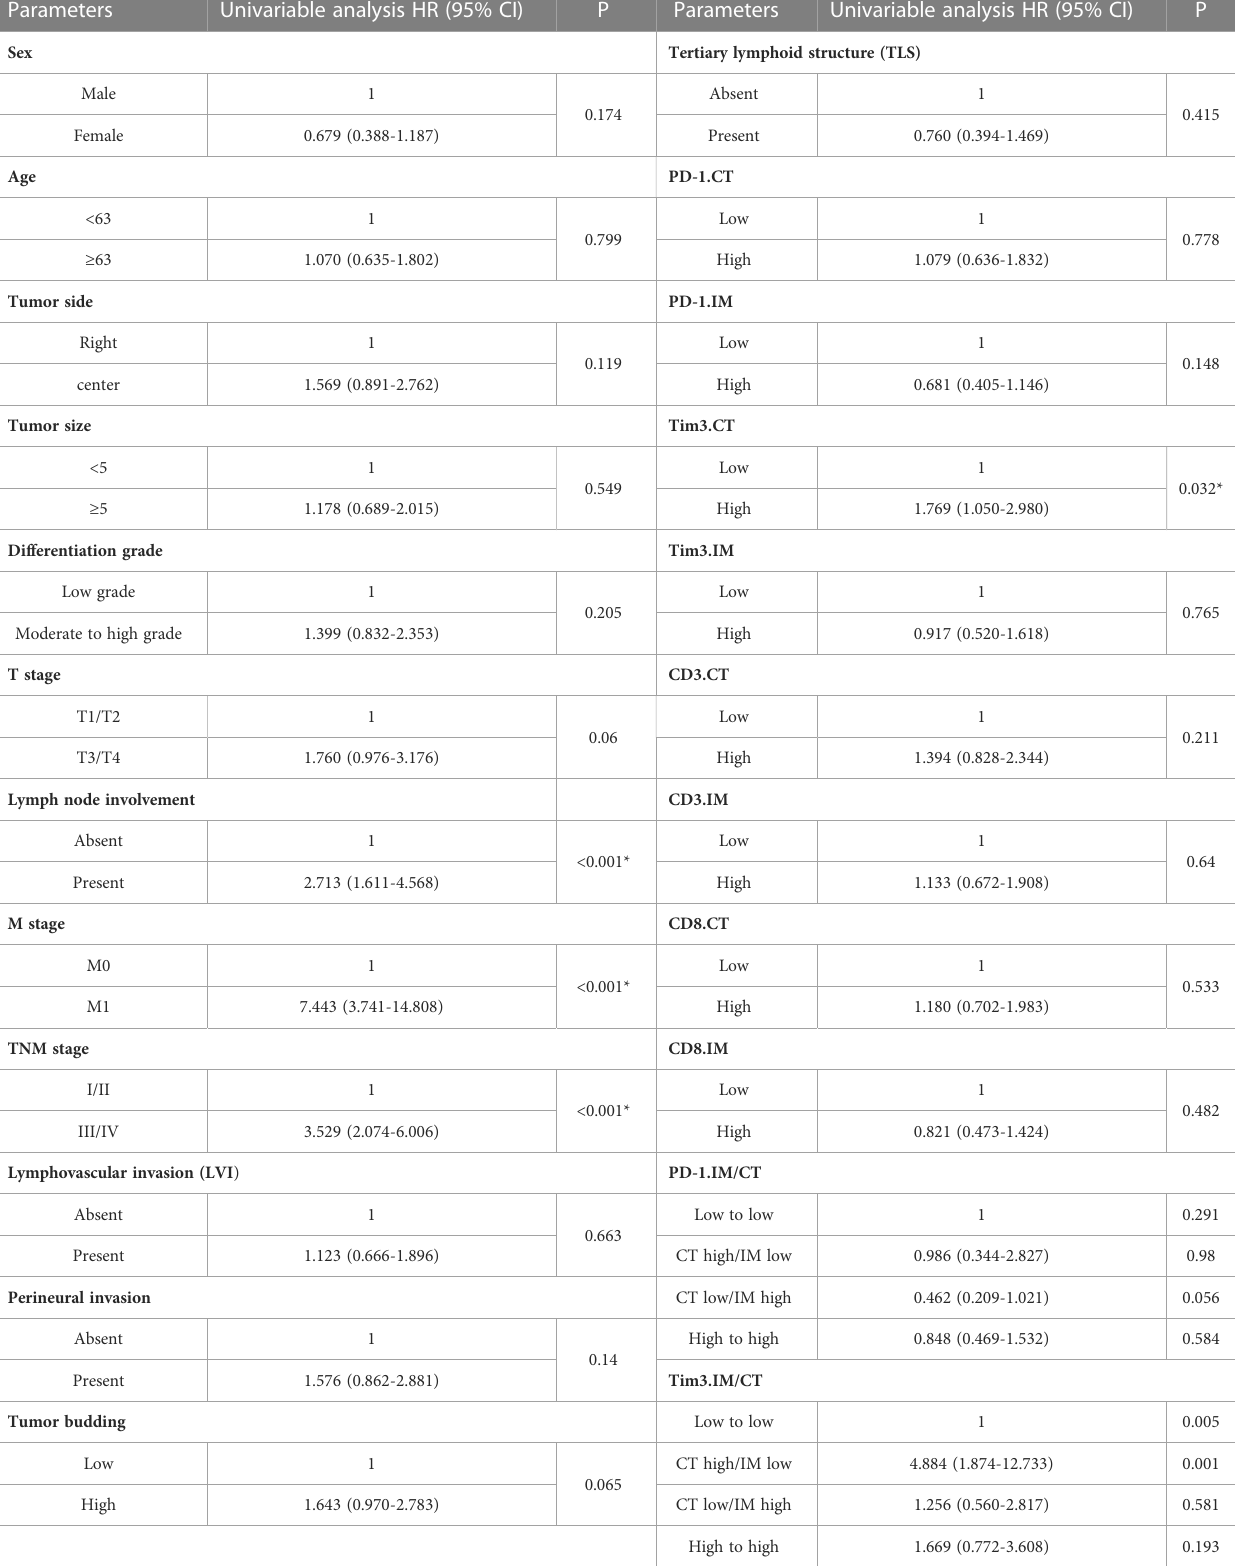
TABLE 5 Univariable survival analysis in the total